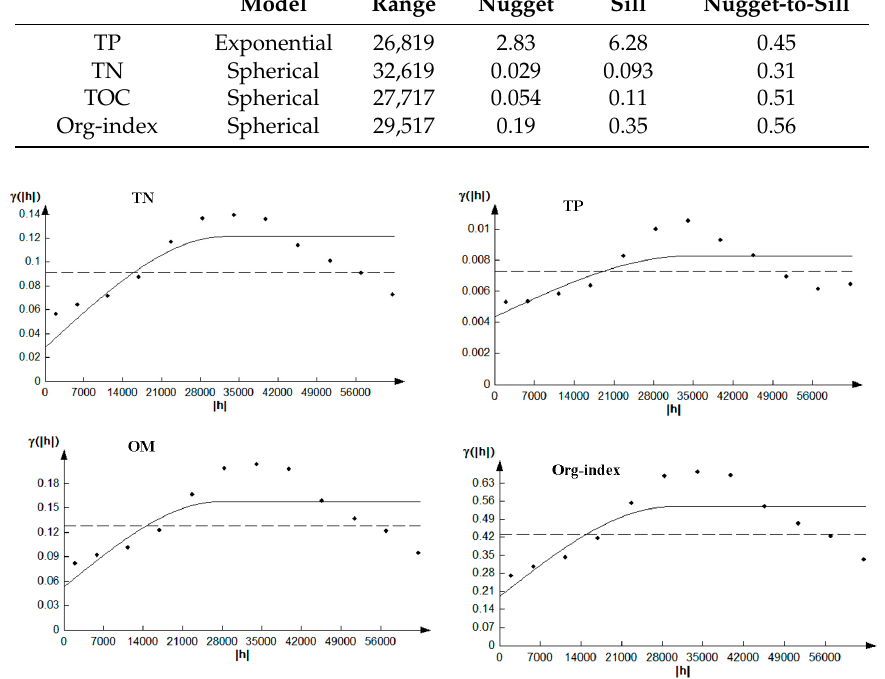
Figure 2. Isotropic semi-variograms of nutrients and its pollution evaluation indexes, |h| stands for the lag distance between sampling sites, ( ) h γ stands for semi-variogram value. Table 2. Parameters of semivariagram models for studied variables.